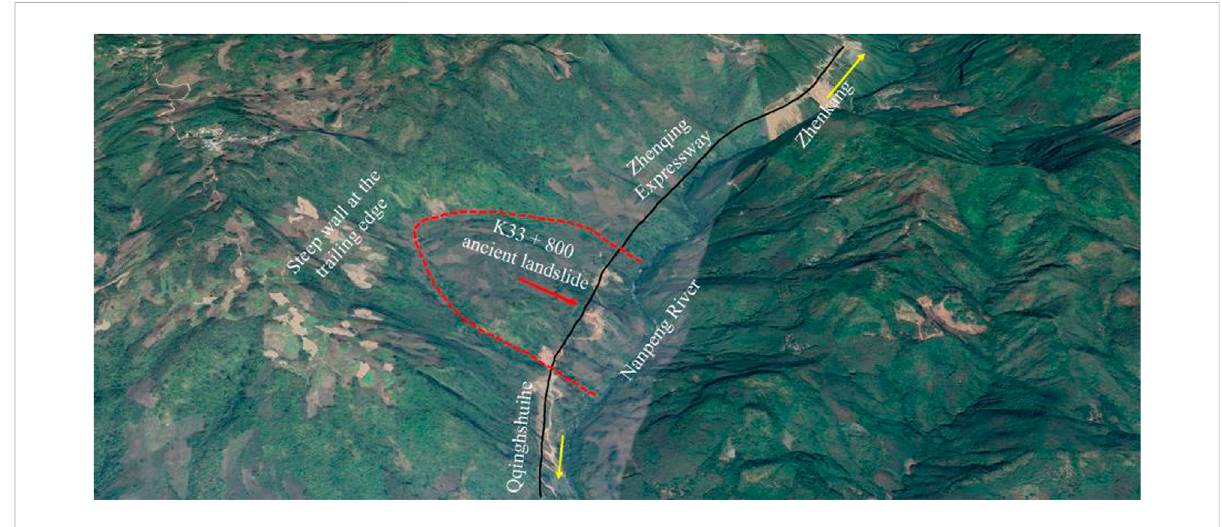
K33 + 800 fault-affected ancient landslide (from Google